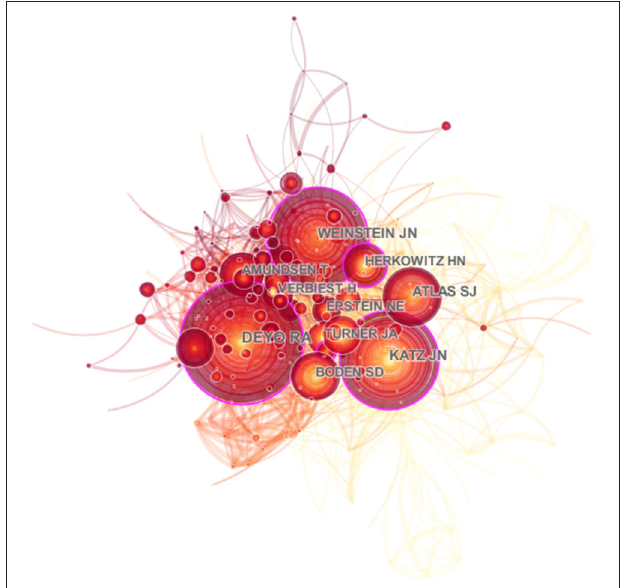
FIGURE 7 | Distribution characteristics of authors. The associated network of co-cited authors.